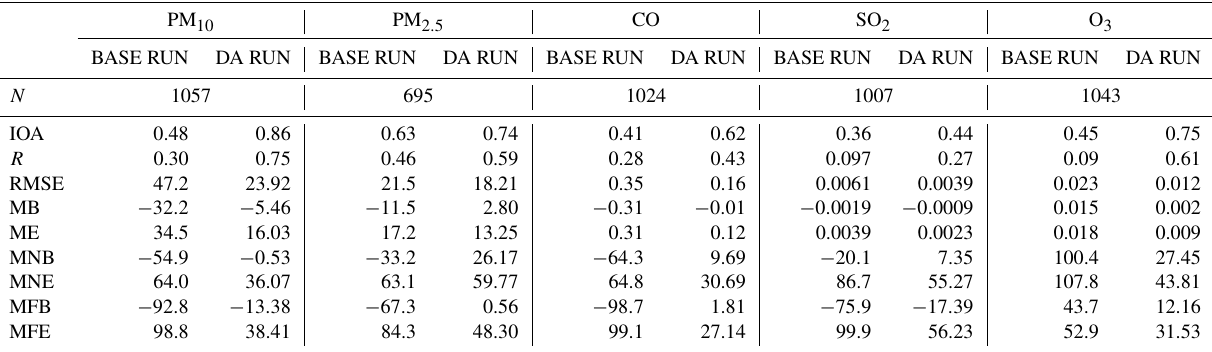
Table 2. Statistical metrics from BASE RUN and DA RUN with Air Korea observations at 00:00UTC when the DA was conducted during the KORUS-AQ